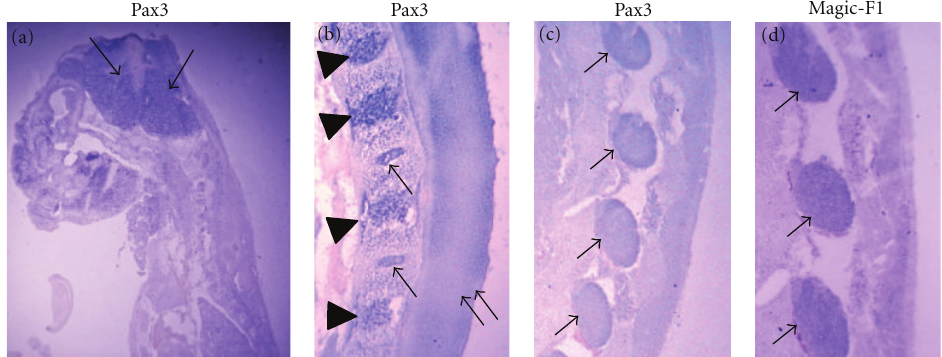
Figure 6: Expression of Pax3 and Magic-F1 at 17.5 dpc. Specific Pax3 transcripts are localized on sagittal sections of 17.5dpc at the level of the head (a), in the nucleus pulposus (b) of lumbar intervertebral disc (arrows) of the trunk, and in cartilage primordium (arrowheads) and wall of spinal cord in midlumbar region (double arrow) as shown in (b) and in cartilage primordium of dorsal part of ribs (c). (d) Magic-F1 signal was observed at the level of cartilage primordium (arrows) of